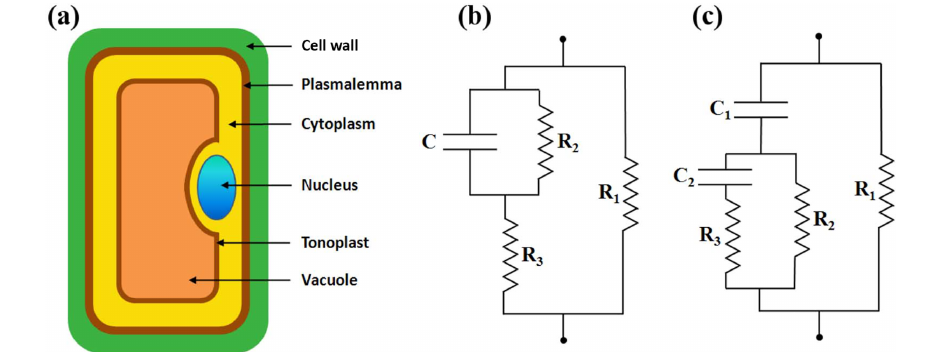
Figure 5. (a) Model of the anatomical structure of a fruit; (b) Hayden equivalent electrical circuit; (c) double-shell equivalent electrical